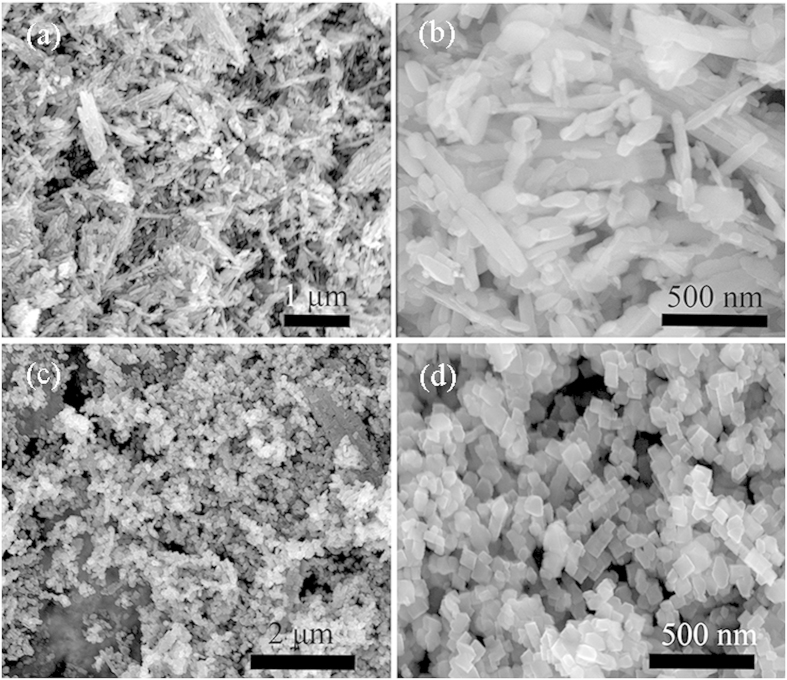
SEM images of the as-prepared TiO2.(a,b) Without NH4F, the obtained TiO2 nanostructures were random shapes. (c,d) With NH4F, regular TiO2 nanoparticles were obtained.